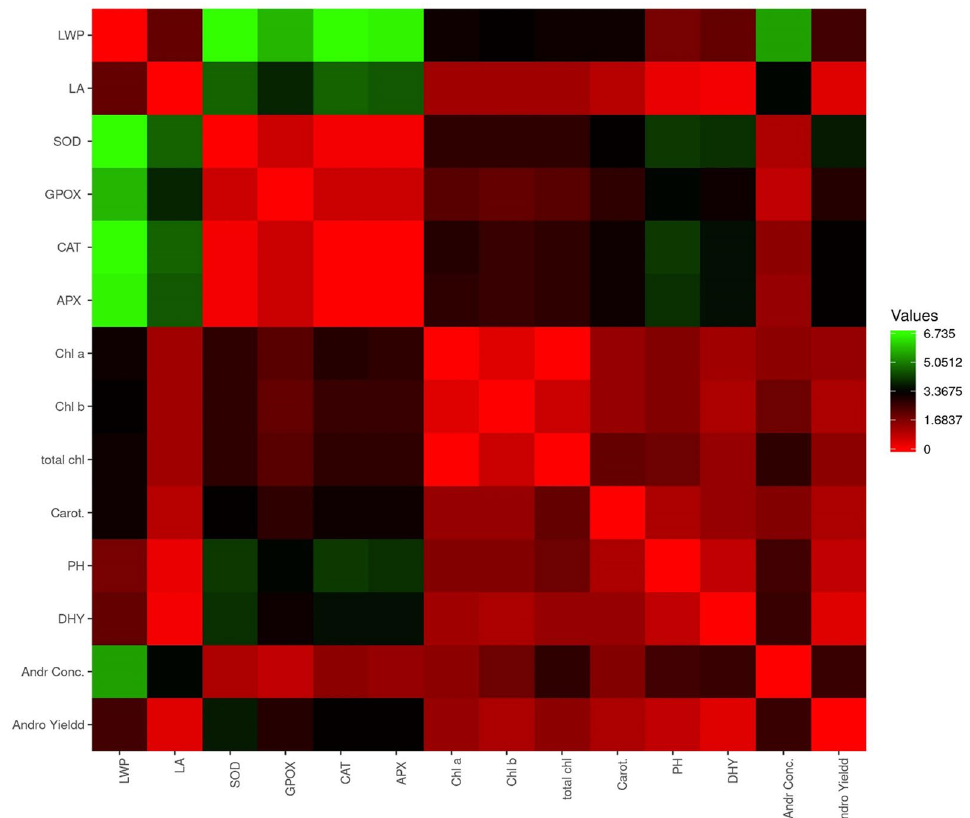
1 to 0.5) is indicated through colours. RWC % (Relative leaf + −